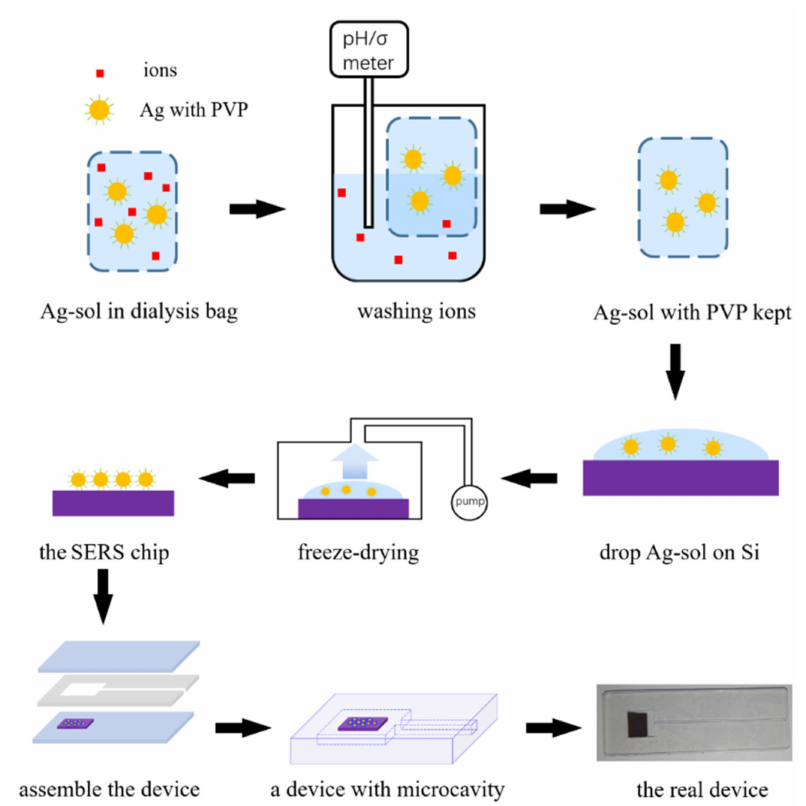
Figure 2. Fabrication process of the surface-enhanced Raman scattering (SERS) device for ethanol